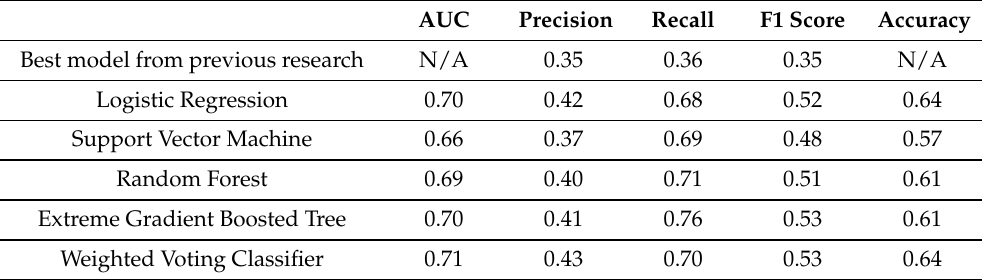
Figure 7. Performance of machine learning models in Diabete detection with Non-diabetic and Diabetic class labels, in terms of precision, recall and F1 score. Table 3. Evaluation metrics of the models from previous research and this research.